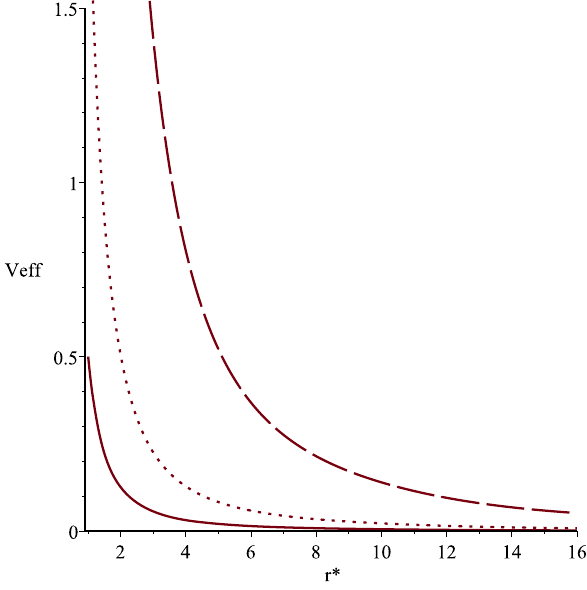
Fig. 14 Plot of the effective potential (49) for = 0, ξ = 0.2, H = 10 with L = 1 (solid line), L = 2 (dotted line) and L = 5 (long dashed line)